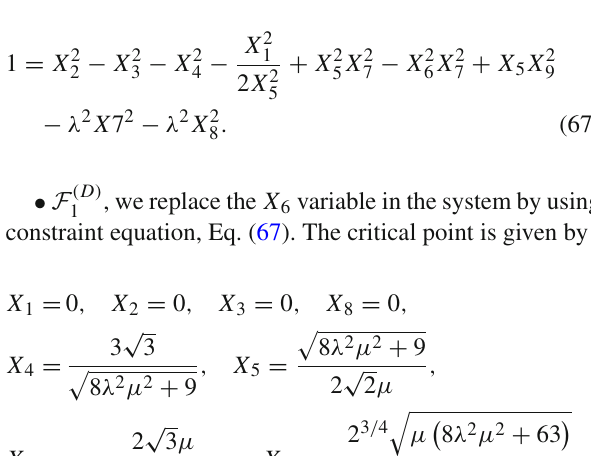
, (cid:12) η and (cid:12) ρ , m 0 1